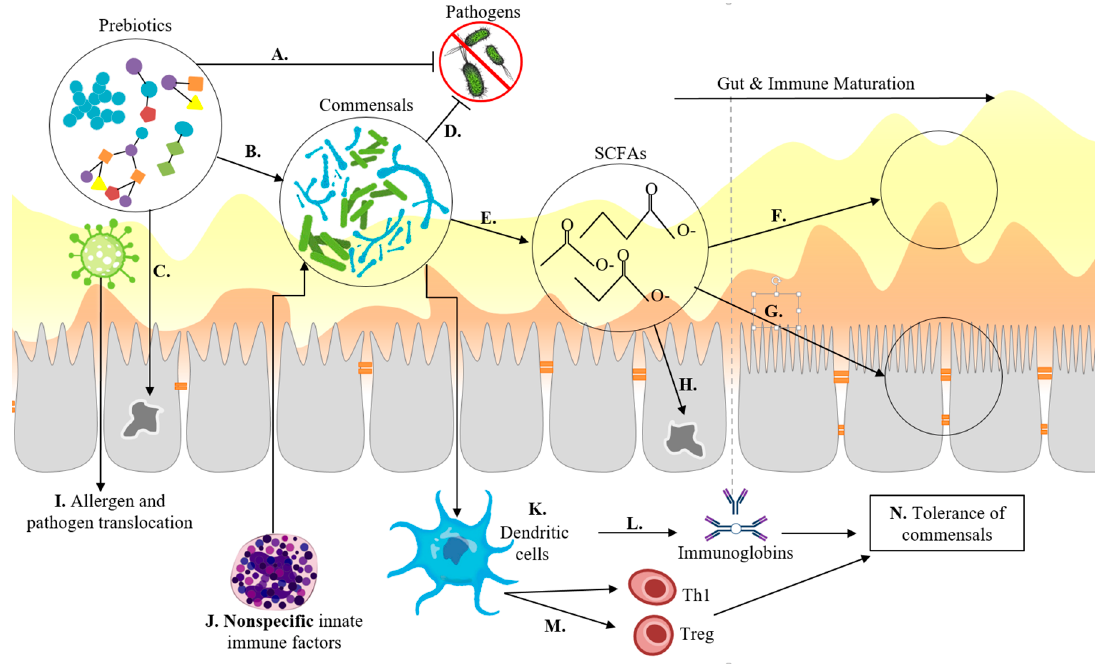
Figure 3. A schematic of multiple mechanisms by which prebiotics modulate immune and gut development. A. Prebiotics bind to pathogens as receptor analogues, preventing adhesion to the epithelial surface and subsequent infection. B. Prebiotics promote populations of commensal microbes, which outcompete pathogens for resources D , reducing infections. C. Prebiotics act directly upon the epithelium promoting the mRNA transcription of proteins involved in barrier integrity. E. Commensal microbes produce metabolites, such as short chain fatty acids (SCFAs), that decrease the lumen pH and increase mucus F , increase TJ proteins and crypt and villi development G , and serve as an energy source for enterocytes that form the epithelium H . In infants, the immature gut is susceptible to allergy and pathogen translocation I through leaky gut barrier. J. Non-specific immune factors, such as macrophages and neutrophils attack commensals and pathogens alike in poorly regulated inflammatory responses. During immune development, dendritic cells K sample commensal microbes, through Toll-Like Receptor (TLR) recognition, allowing for antigen specific immunoglobin production L and promoting the differentiation of T and B cells M , resulting in improved tolerance to commensals and targeted response to pathogens N .